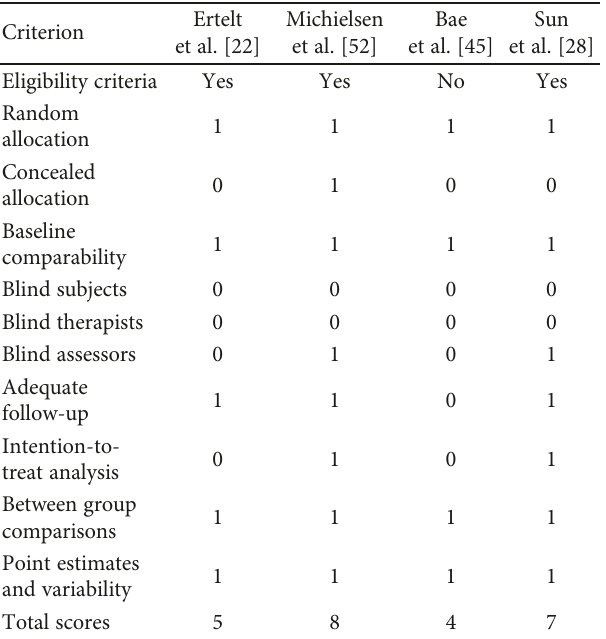
Table 4: Methodological assessment of included studies using the PEDro scale ∗